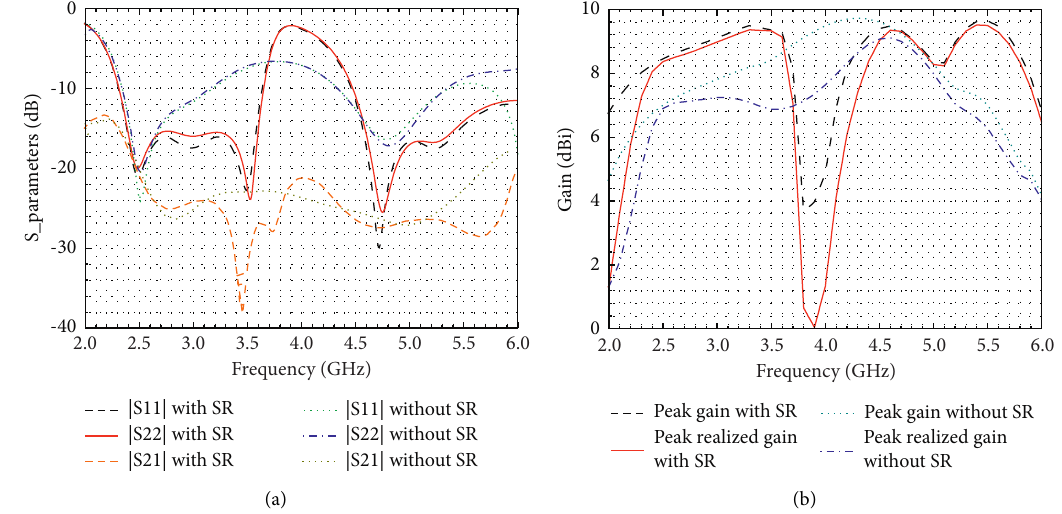
Figure 5: Comparison with and without the SR: (a) S parameters and (b) gains.